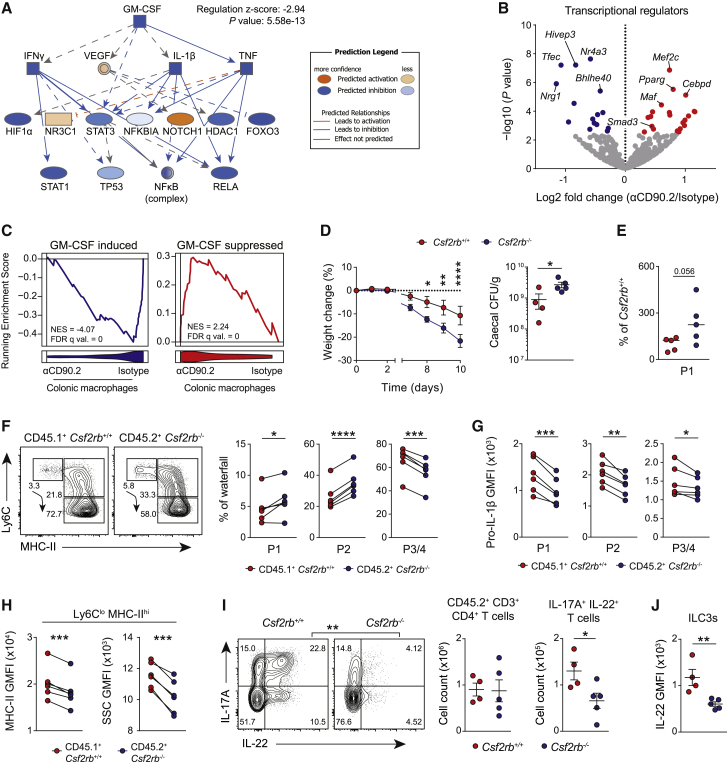
GM-CSF Drives Inflammatory Macrophage Function and Type 17 Immunity In Vivo(A) GM-CSF-associated upstream regulatory network downregulated by anti-CD90.2 IgG treatment, derived by IPA, in colonic Ly6Clo MHC-II+ macrophages from Rag2−/− mice treated with 2% DSS ± isotype or anti-CD90.2 IgG. n = 6 per group.(B) RNA-seq volcano plot of transcriptional regulators (GO:0140110) from macrophages in (A).(C) GSEA of the GM-CSF signatures (top 200 GM-CSF-induced (left) or GM-CSF-suppressed (right) genes in BMDMs) in colonic Ly6Clo MHC-II+ macrophages from (A). GM-CSF signatures derived from ArrayExpress: E-MTAB-792.(D) Weight change (left) and cecal CFU at 10 dpi (right) in 100% Csf2rb+/+ and 100% Csf2b−/− bone marrow chimeras infected with C. rodentium. Mean ± SEM indicated. n = 5 per group.(E) Proportion of P1 monocytes of total CX3CR1+ CD11b+ MNPs in bone marrow chimeras, normalized to Csf2rb+/+ mice.(F and G) Waterfall subset frequency (F) and pro-IL-1β expression (G) of paired Csf2rb+/+ and Csf2rb−/− colonic MNP subsets in 80:20 bone marrow chimeric mice at 7 dpi with C. rodentium.(H) MHC-II expression and side scatter of Ly6Clo MHC-II+ macrophages in (F).(I and J) Type 17 cytokine production by CD4+ T cells (I) and ILCs (J) in 100% Csf2rb+/+ or 100% Csf2rb−/− bone marrow chimeric mice at 10 dpi with C. rodentium.Mean ± SEM indicated. n = 4–5 per group. Data are representative of two independent experiments. p values were calculated using IPA software (A), standard DESeq 2 method with multiple comparisons correction using the Benjamini-Hochberg procedure (B), two-way ANOVA with Sidak’s multiple comparisons test (D) (weight loss), Student’s t test (D [CFU analysis], I, and J), Mann-Whitney U test (E), and a paired t test (F–H). ∗p < 0.05; ∗∗p < 0.01; ∗∗∗p < 0.001; ∗∗∗∗p < 0.0001. See also Figure S3.